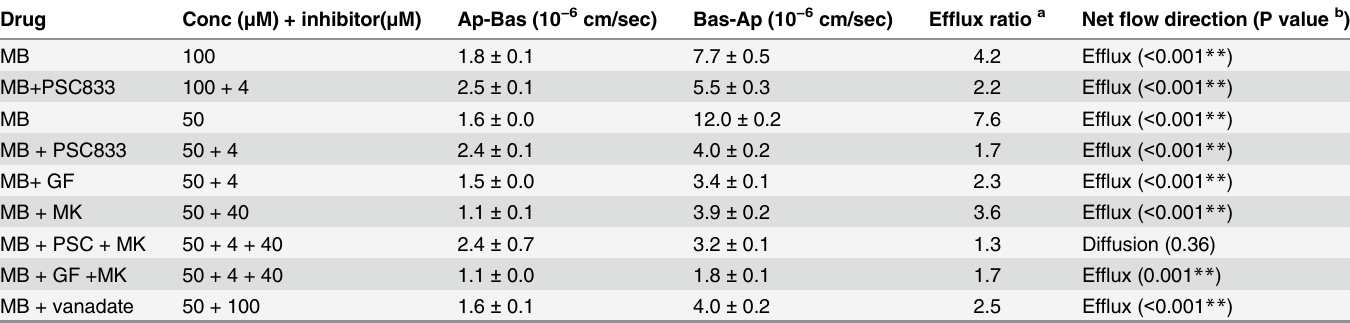
Table 3. Apparent permeability (P app ± SEM) and efflux ratio of methylene blue through Caco-2 cell monolayer.